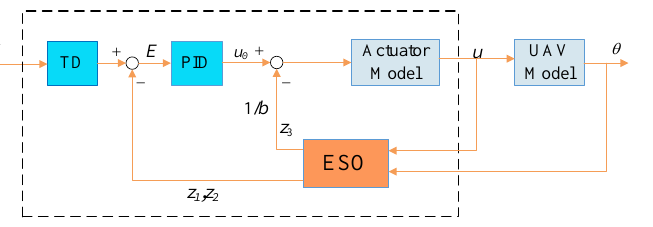
Figure 2. Structure of ADRC; θ is the desired angle of pitch and b is the estimation of system